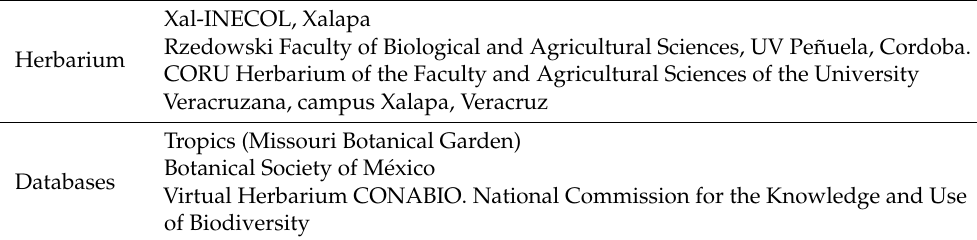
Table 2. Sources of information for mapping the distribution of Vitis tiliifolia in the state of Veracruz, M é xico.